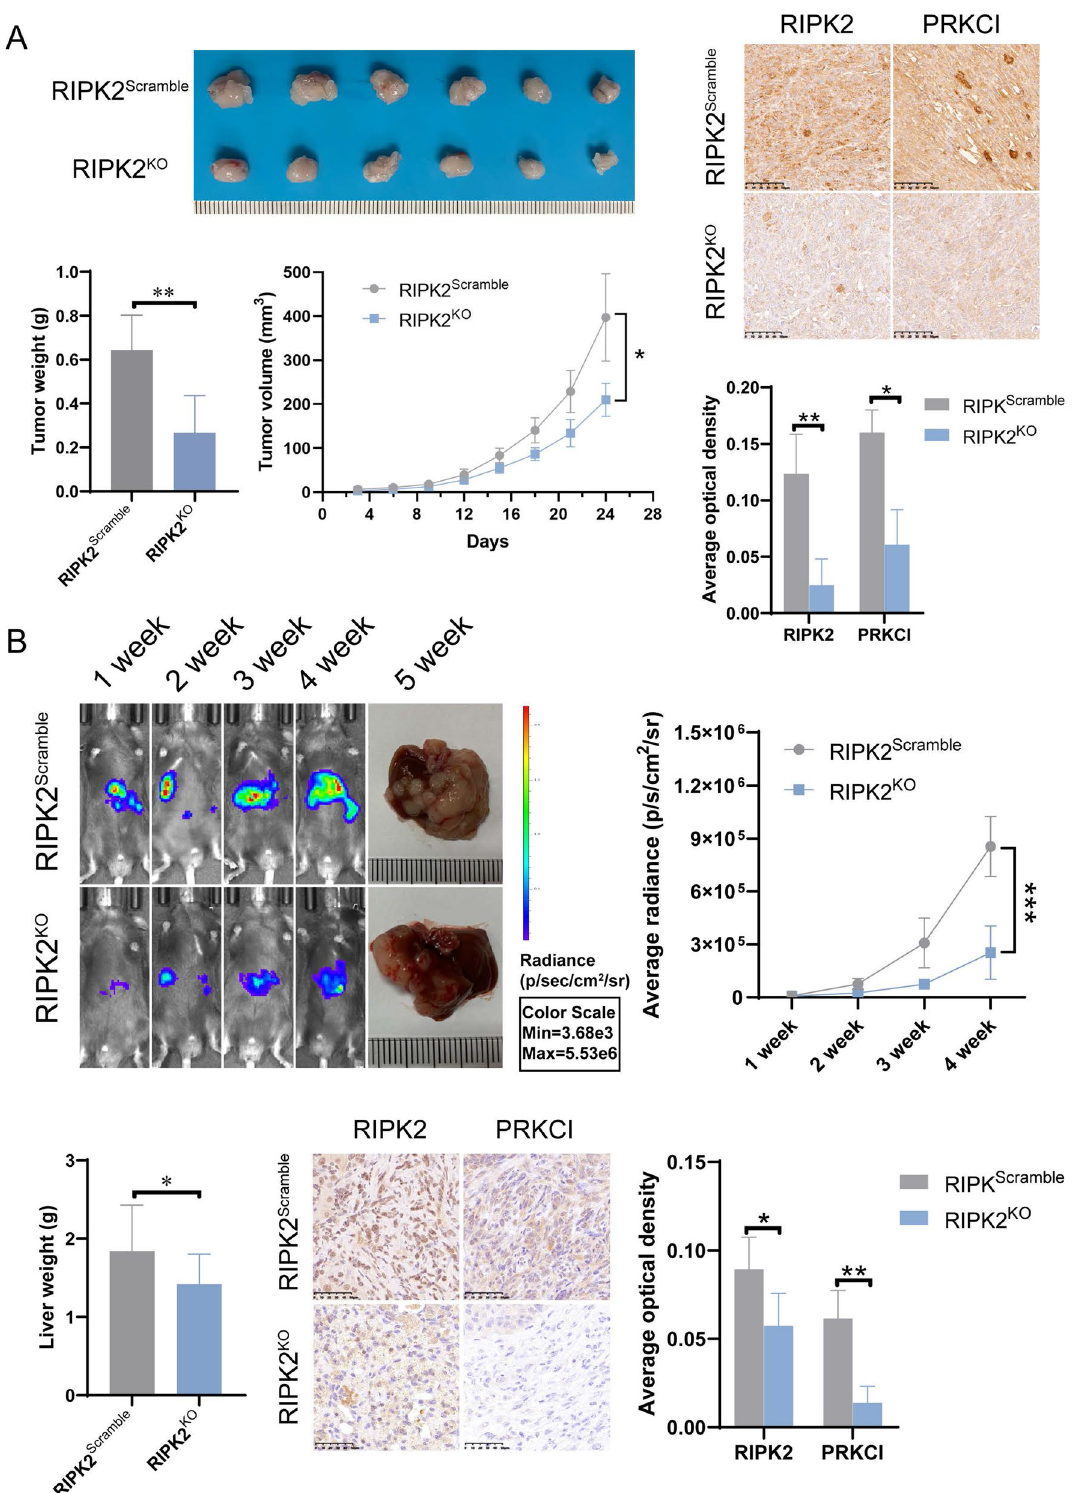
Fig. 6 RIPK2 knockout inhibited subcutaneous tumor growth and liver metastasis of pancreatic cancer. A Comparison of subcutaneous tumors weight, growth rate, RIPK2 and PRKCI expression. B Comparison of liver metastatic rate, and the expression of RIPK2 and PRKCI in the metastatic sites. * p < 0.05, ** p < 0.01, *** p <